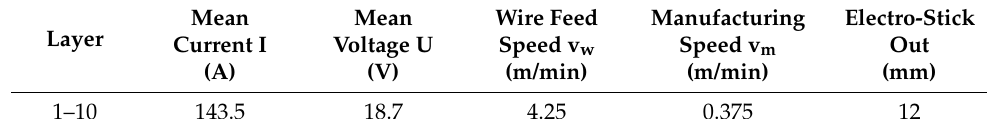
Table 1. Wire arc additive manufacturing process parameters.